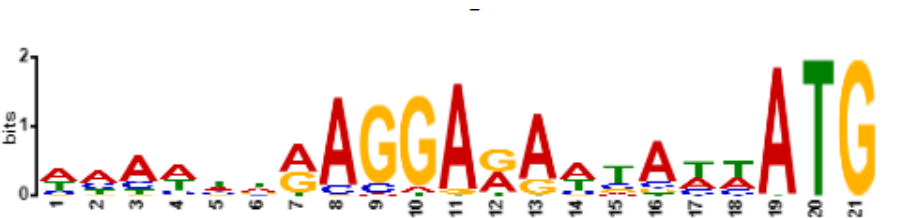
Figure 6. Shine–Dalgarno motif (ribosome binding site) in sequences of 100 bp upstream of START codon (included) for phage Entb_43, identified by XSTREME software.